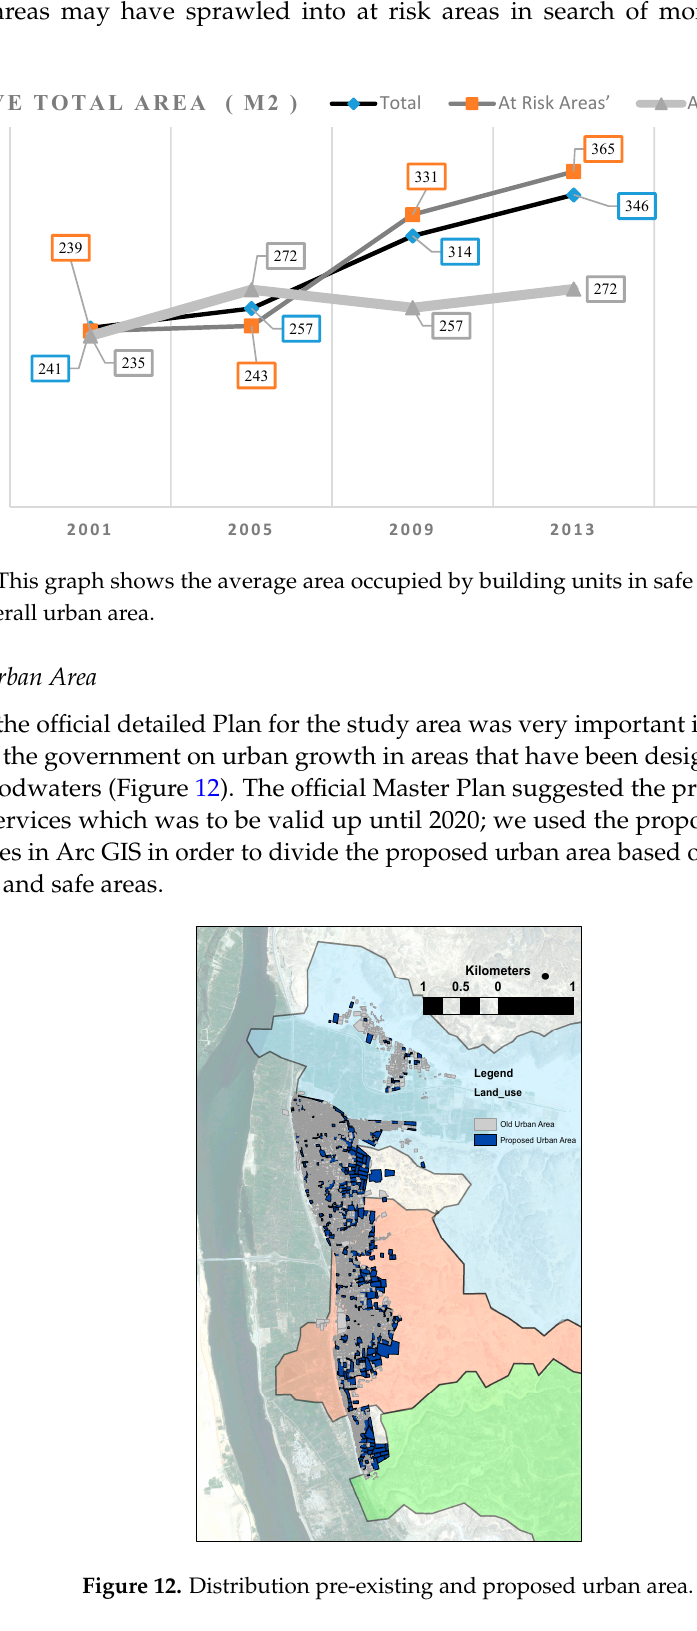
Figure 12. Distribution pre-existing and proposed urban area.